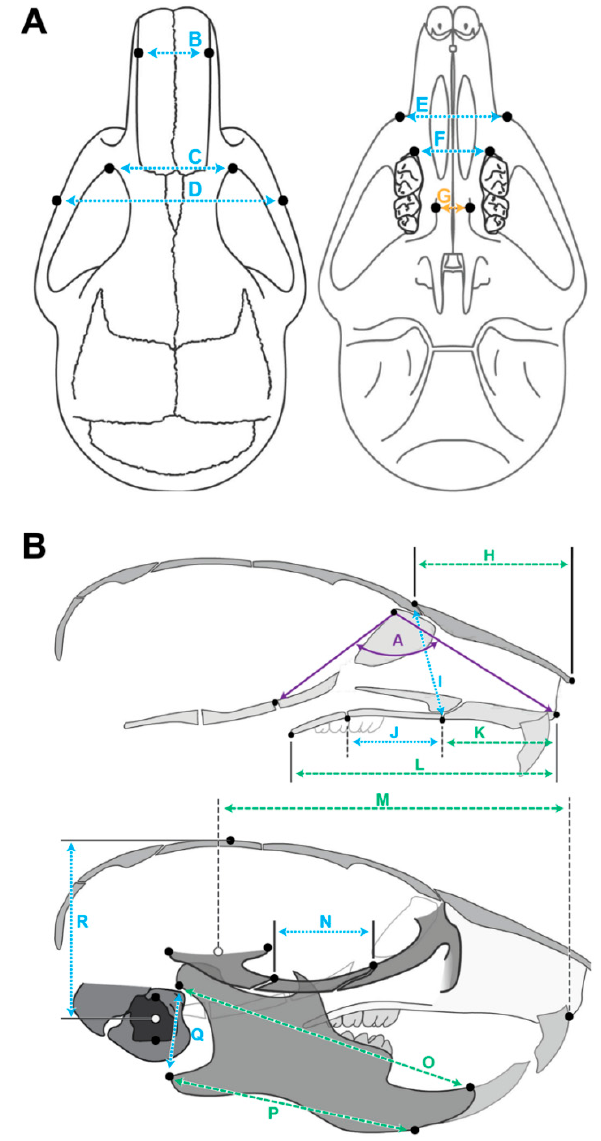
Figure 1. Schematic of craniofacial measurements and landmarks. ( A ) Dorsal (left) and ventral (right), as well as ( B ) lateral interior (top) and exterior (bottom) landmarks were placed at the points indicated by black dots. Measurements are represented by double-sided arrows. Measurements that have significant differences between control and Thm2 − / − ; Thm1 aln/+ mice in true measurements are indicated by dotted blue lines. Measurements that have significant differences between control and Thm2 − / − ; Thm1 aln/+ mice as both true and cranium centroid measurements are indicated by green dashed lines. The measurement that was significantly wider in Thm2 − / − ; Thm1 aln/+ mice relative to control mice relative to cranium centroid size is indicated by orange dashed lines. Angular measurement is indicated by solid purple lines. (A) Snout angle, (B) Anterior nasal width, (C) Inter- orbital width, (D) Inter-zygomatic arch width, (E) Inter-maxillary width, (F) Inter-(1st)molar width, (G) Palatal width (H) Nasal length, (I) Facial height, (J) Maxillary length, (K) Premaxillary length, (L) Facial region length, (M) Upper jaw length, (N) Zygomatic length, (O) Mandibular superior and (P) inferior length, (Q) Mandibular posterior height, and (R) Ear height. All analyzed landmarks and measurements, including those not significantly different between control and Thm2 − / − ; Thm1 aln/+ mice, are provided in Supplemental Table